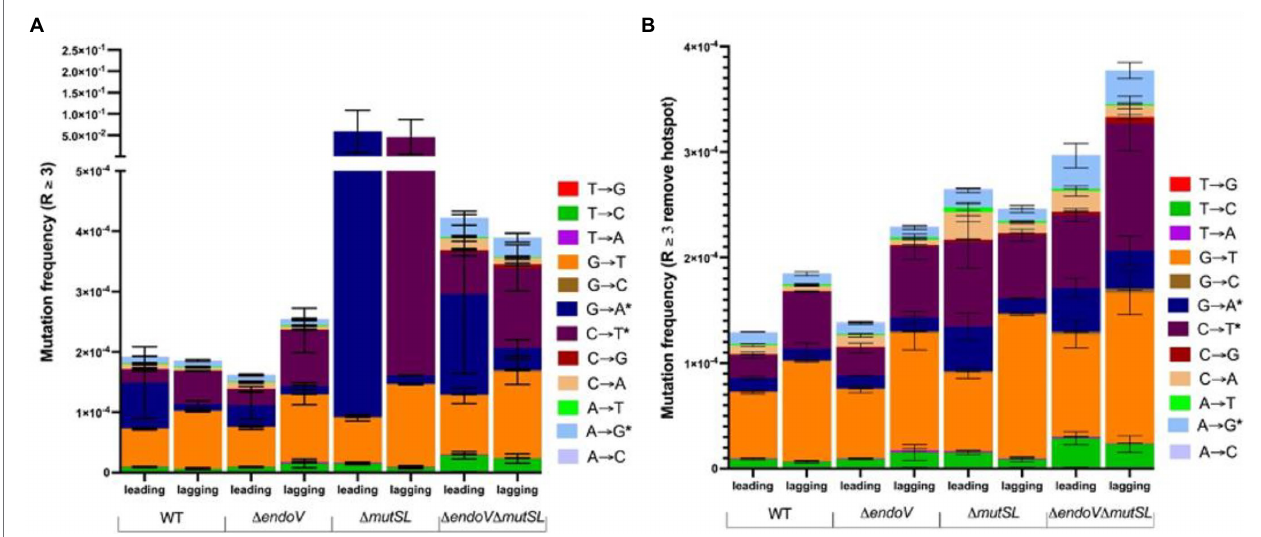
FIGURE 3 | (A) Mutation frequencies for the strains indicated, depicting the contribution of base substitutions produced from base deamination (*) and from other types of base damages. (B) Mutation frequencies as shown in A but excluding position 14 corresponding to the first position of codon 482. Each section of the bars represents the mean frequency of two biological replicates. The frequency of each replicate was calculated using the sum of the specific change in the 68-bp ROI divided by the number of important/nodes or families. Error bars are